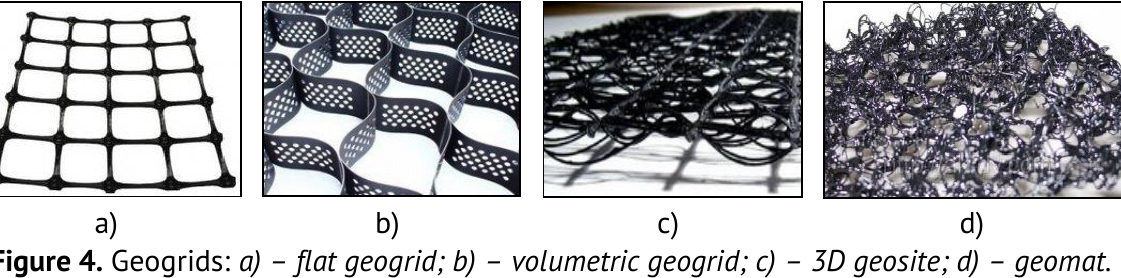
Figure 4. Geogrids: a) – flat geogrid; b) – volumetric geogrid; c) – 3D geosite; d) –